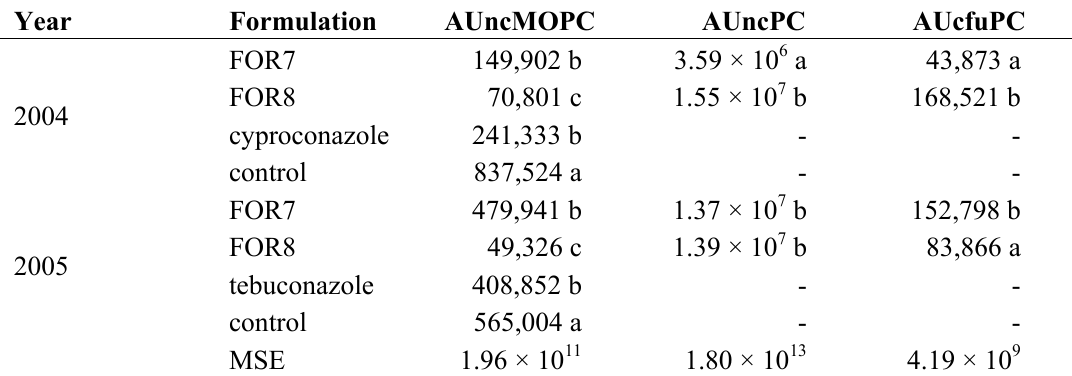
Table 1. Effect of the Epicoccum nigrum (FOR7) and Penicillium frequentans (FOR8) conidial formulations on the area under progress curve for the number of Monilinia spp. conidia (AUncMOPC) and the number of E. nigrum or P. frequentans conidia (AUncPC), and the area under progress curve for the number of colony-forming units (CFU) of E. nigrum or P. frequentans (AUcfuPC) for the surfaces of “Red September” peaches from a commercial orchard in Alfarrás, Spain in 2004 and 2005.